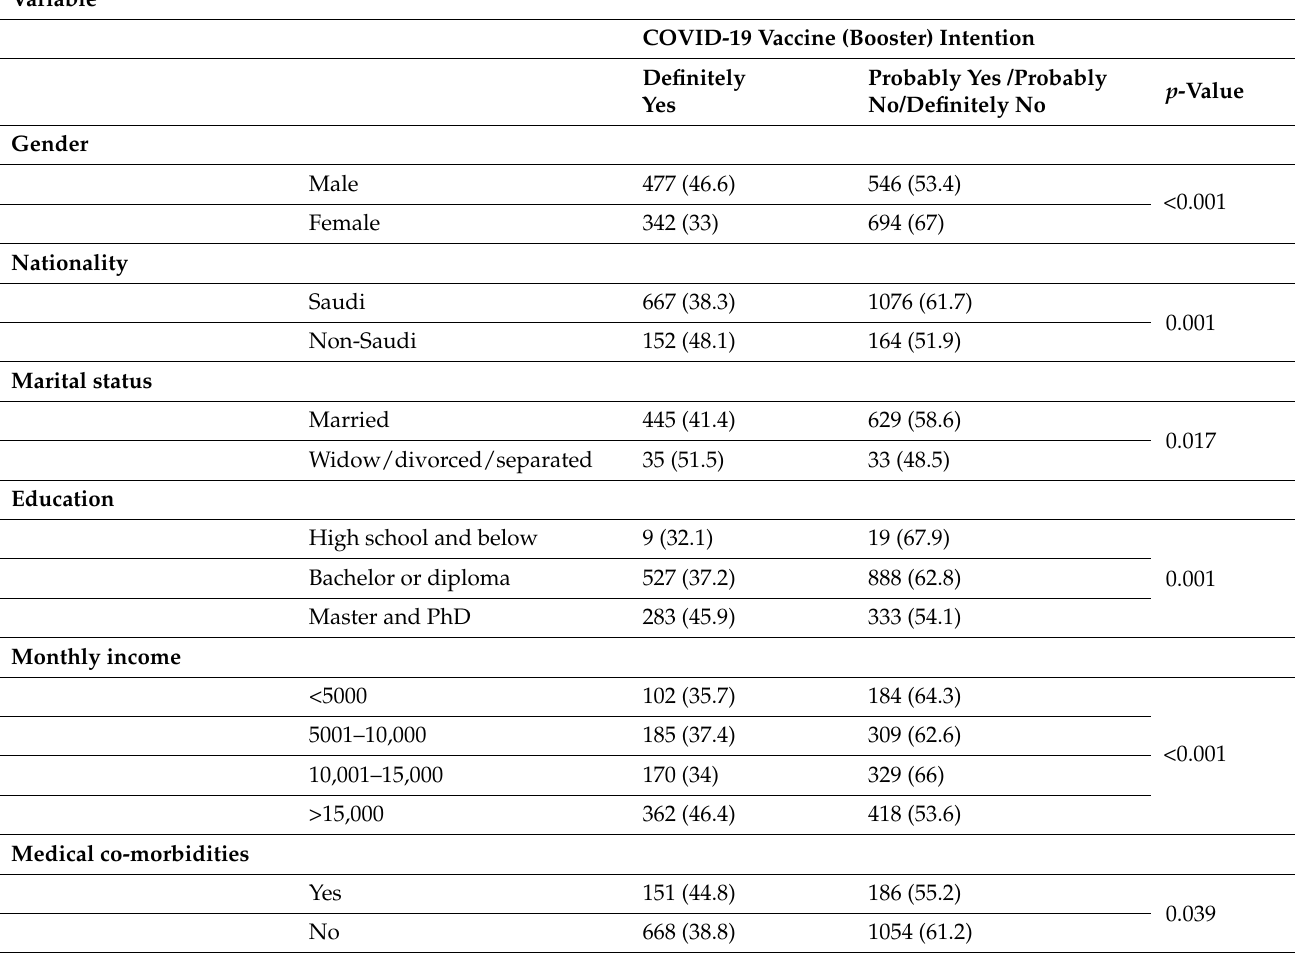
Table 3. Association between socio-demographic and clinical variables and COVID-19 vaccine third dose (booster)